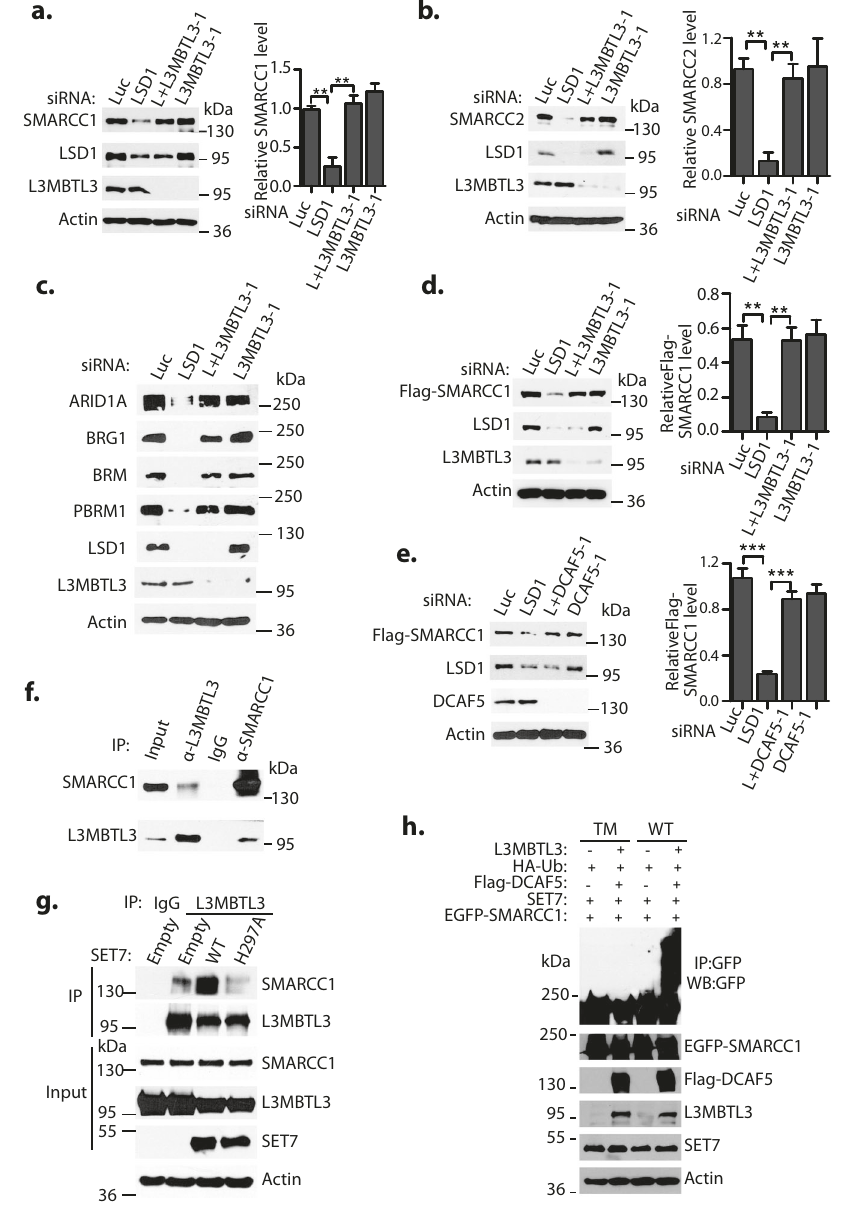
Fig. 2 | Regulation of SMARCC1 and SMARCC2 by L3MBTL3 and DCAF5. a – c L3MBTL3 silencing stabilizes endogenous mSWI/SNF proteins in HeLa cells. HeLacellsweretransfectedwith50nMsiRNAsofluciferase,LSD1,LSD1+L3MBTL3 (L+L3MBTL3), or L3MBTL3 for 48h. The representative levels of SMARCC1 ( a ), SMARCC2 ( b ), and other indicated mSWI/SNF proteins ( c ) were analyzed by Wes- tern blotting. Band intensities were quanti fi ed and normalized to the Luciferase (Luc) siRNA control signal, as described in Fig. 1e. d H1299 cells stably expressing Flag-SMARCC1 were transfected with 50nM of luciferase, LSD1, LSD1+L3MBTL3, and L3MBTL3 siRNAs for 48h and Flag-SMARCC1 levels were analyzed by Western blotting. e DCAF5 silencing stabilizes Flag-SMARCC1. H1299 cells expressing Flag- SMARCC1 were transfected with 50nM of luciferase, LSD1, LSD1+DCAF5, and DCAF5 siRNAsand quantitatively analyzed as 2d . f Endogenous L3MBTL3interacts withSMARCC1.L3MBTL3andSMARCC1wereimmunoprecipitatedfrom293Tcells